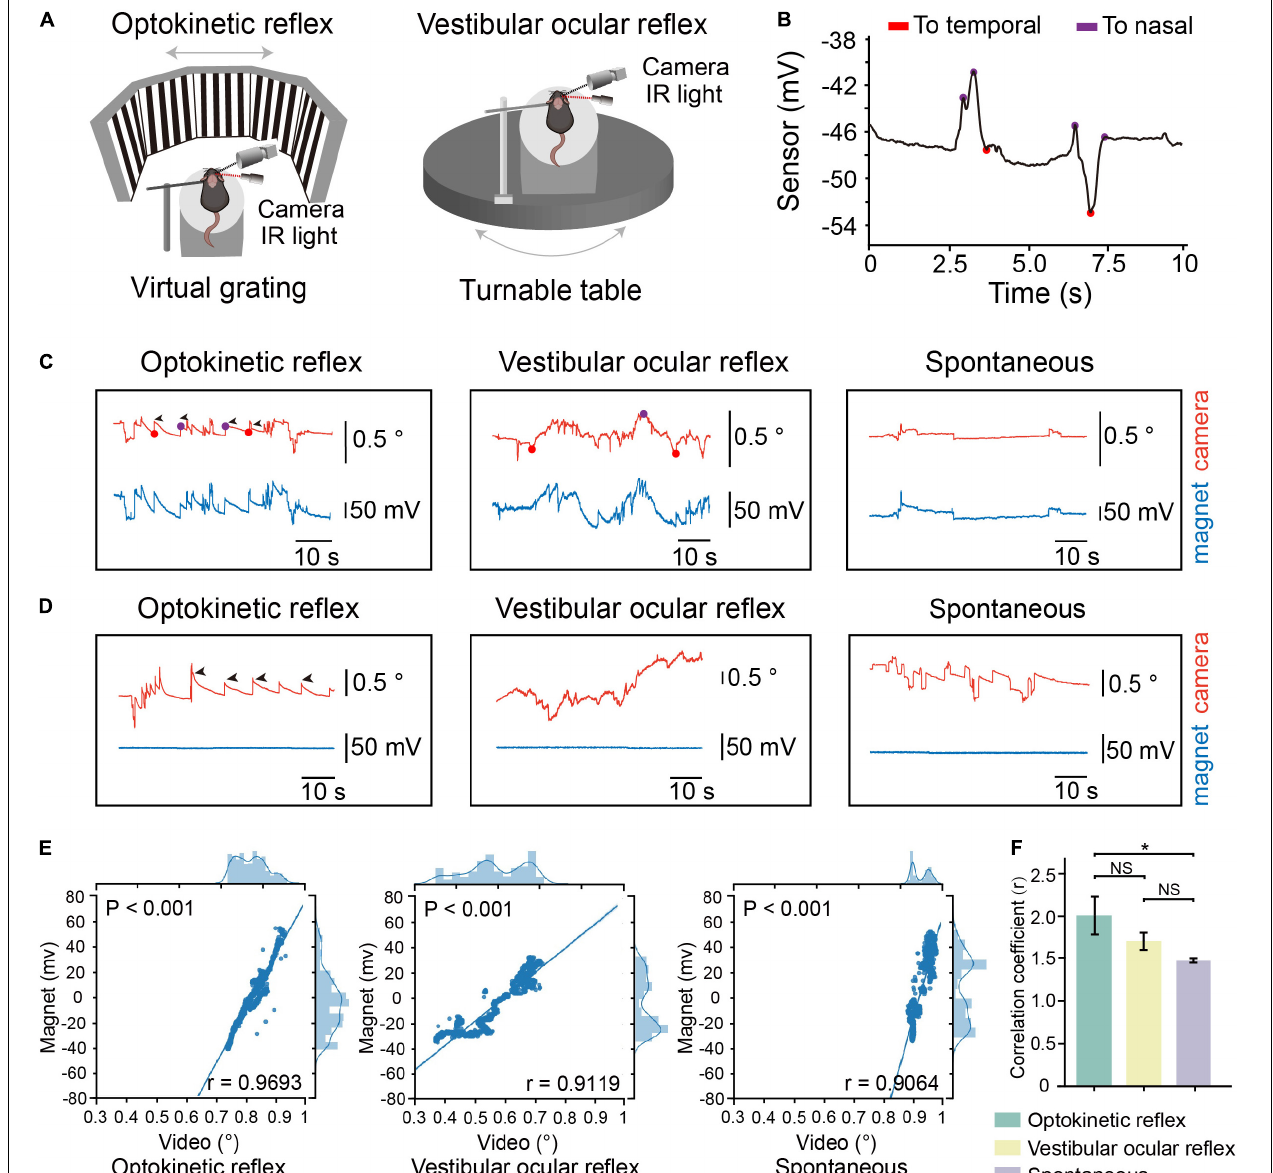
FIGURE 2 | Comparation of eye movements tracking by the device and video-oculography. (A) Schematic representation of experimental setup for tracking eye movements during optokinetic reflex (OKR) recording (Left) or vestibular ocular reflex (VOR) recording (Right) . (B) Motion direction of eye analyzed from eye movements raw trace. Red dots, the timepoint when eye move to temporal. Purple dots, the timepoint when eye move to nasal. (C) Example of OKR induced eye movements (left) , VOR induced eye movements (middle) or spontaneous eye movements from one mouse with magnet implanted on conjunctiva. Red line: relative eye position measured by video-oculography. Blue line: relative eye position measured by magnetic sensor. (D) Example of OKR induced eye movements (left) , VOR induced eye movements (middle) or spontaneous eye movements from one mouse with magnet implanted on skull. (E) Scatterplot of eye position recorded by magnetic sensor and video-oculography for one representative mouse. Solid line represents fitted linear regression. The curve in top axis represents eye position distribution recorded by video-oculography. The curve in right axis represents eye position distribution recorded by magnetic sensor. (F) Mean correlation coefficients between signals by video-oculography and magnetic approaches during different eye movement patterns ( n = 4, data were first processed with Fisher z transformation and one-way repeated measures ANOVA followed by post hoc comparison with Tukey’s correction was performed afterward, NS: not significant). Data are expressed as mean ± SEM, * p <